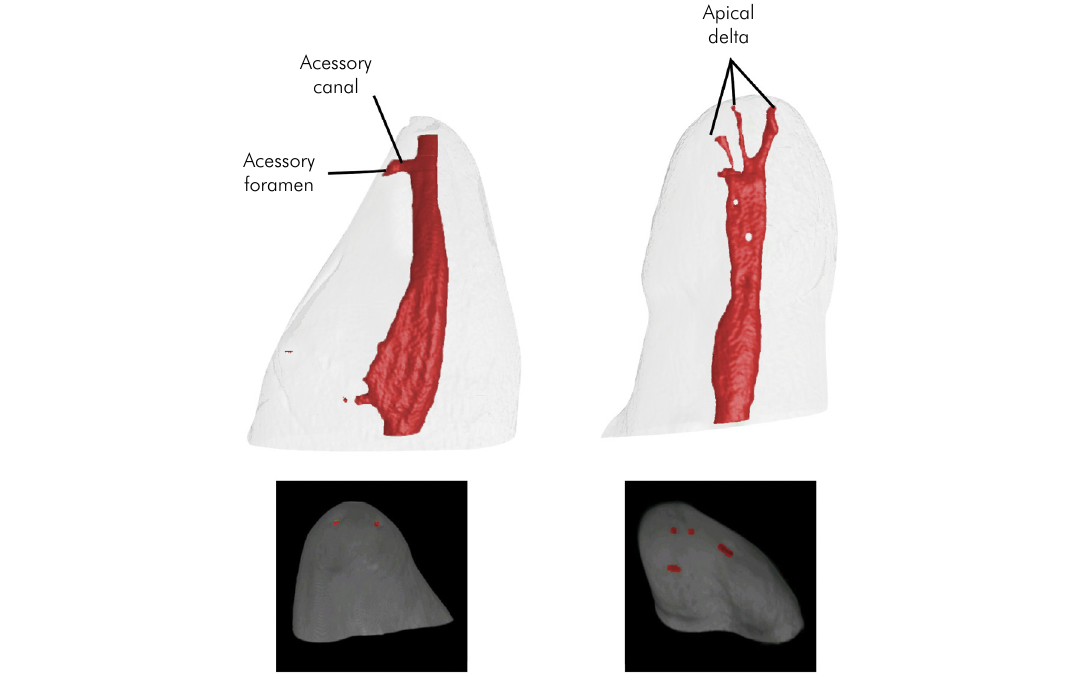
Figure 1. Reconstruction micro-CT image representations showing the accessory canal, accessory foramen, and apical